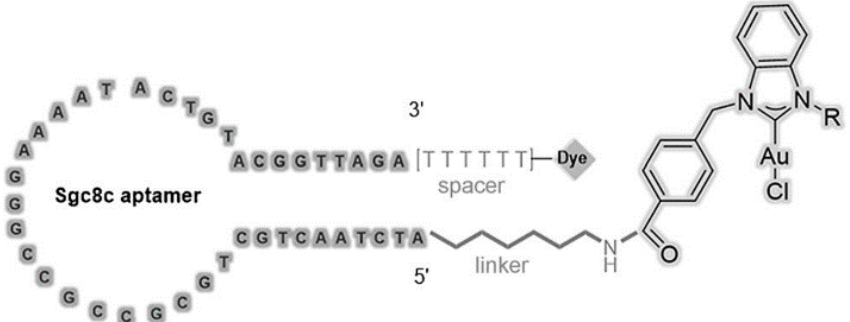
Figure 5. Schematic illustration of aptamer-NHC-Au1 conjugate. Reprinted with permission from © (2016) WILEY-VCH Verlag GmbH & Co. KGaA [48].